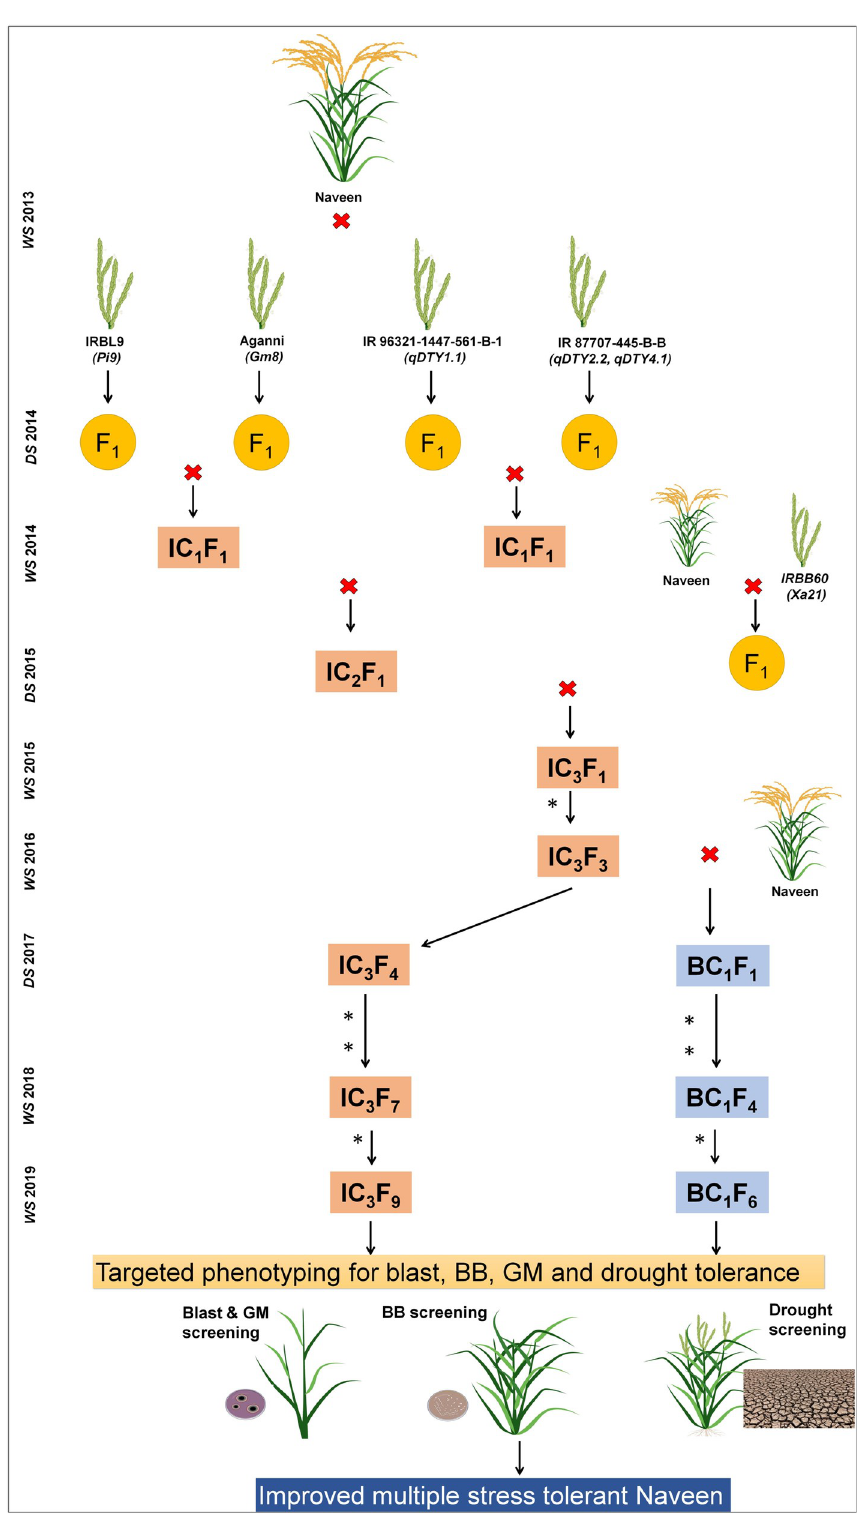
Fig 1. Flow diagram depicting the different steps involved in development of gene/QTL pyramids of Naveen through Marker-Assisted Forward Breeding (MAFB) and Marker-Assisted Backcross Breeding (MABC). � Generation advancement by